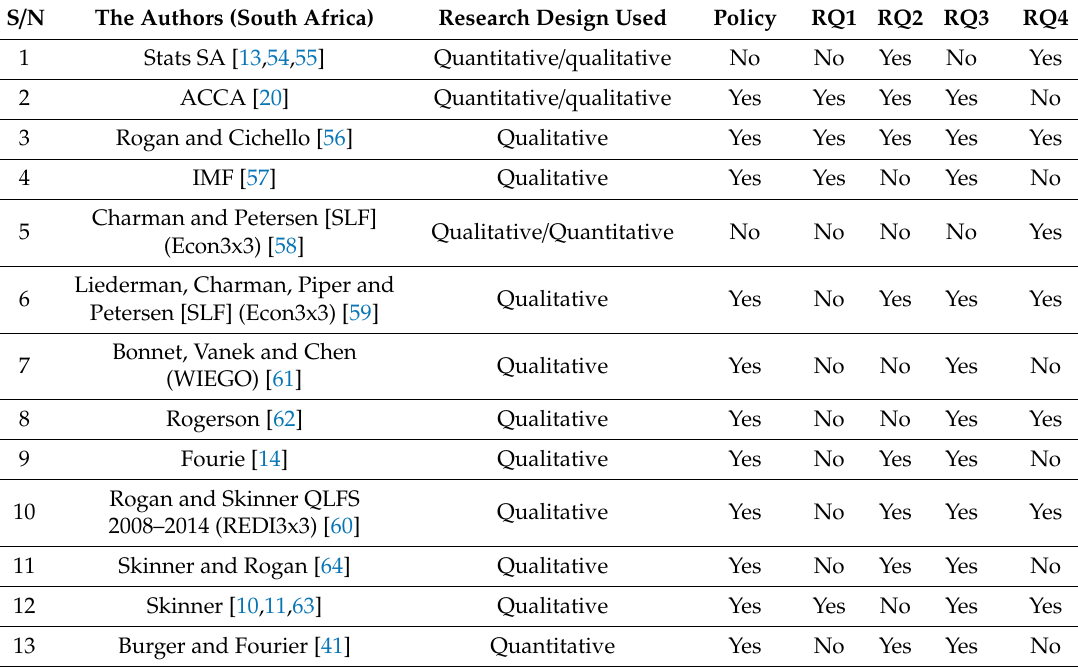
Table 9. Extracted papers on South Africa.